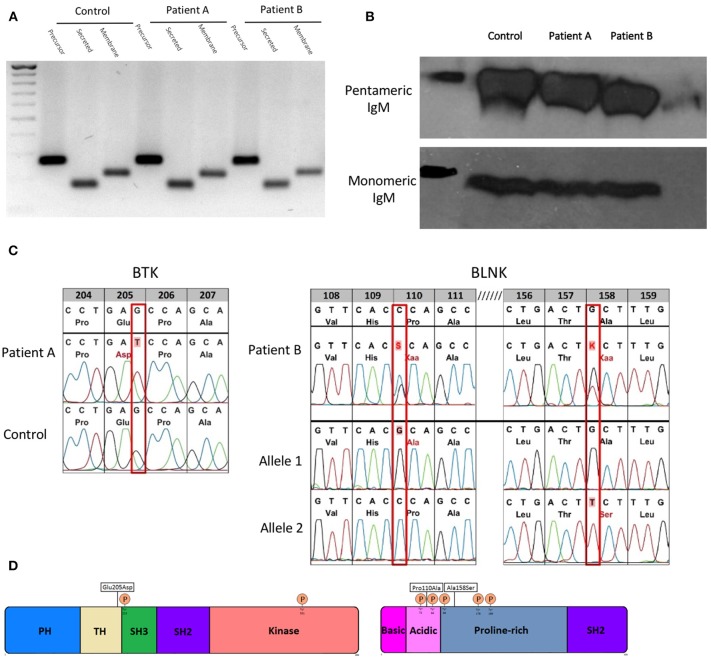
Molecular characterization of novel hypomorphic BTK/BLNK mutations. (A) Gene expression of precursor, secreted and membrane IgM of patients and control EBV-LCL quantified by semi-quantitative cDNA-PCR. (B) Protein expression of monomeric and pentameric IgM of patients and control EBV-LCLs by SDS-PAGE or native-PAGE and detected by western blot. (C) BTK/BLNK Mutation analysis of genomic DNA from peripheral blood. Patient A is hemizygote for a c615G>T in BTK. Patient B is compound heterozygous in BLNK for c328C>G, c472G>T. Healthy controls served as wild type control. (D) Schematic depiction of mutation sites and phosphorylation sites in BTK and BLNK.